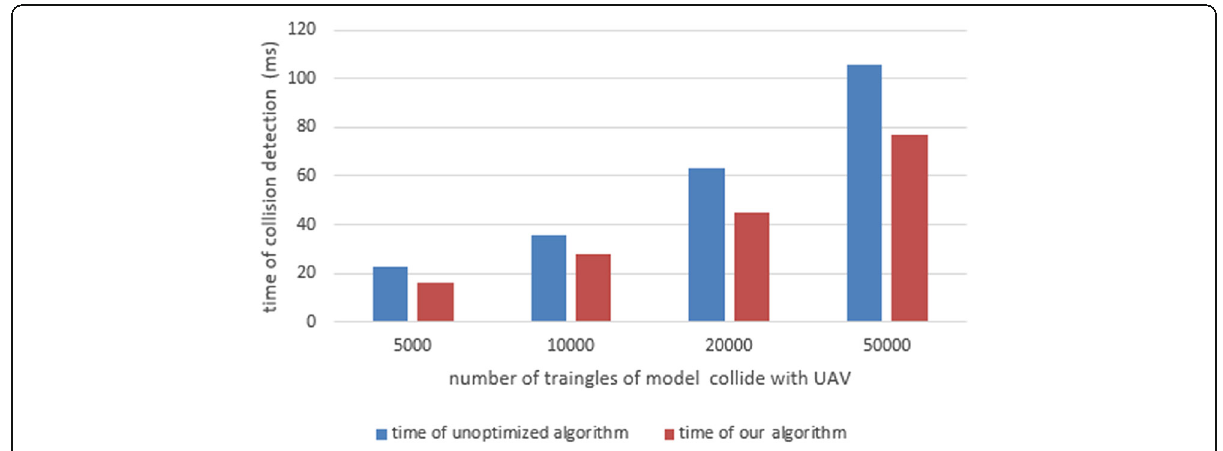
Fig. 9 The time of collision detection of our algorithm compared with un-optimized